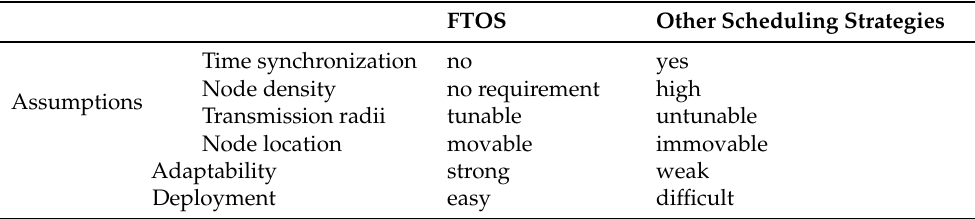
Table 6. The differences between FTOS and other scheduling strategies.